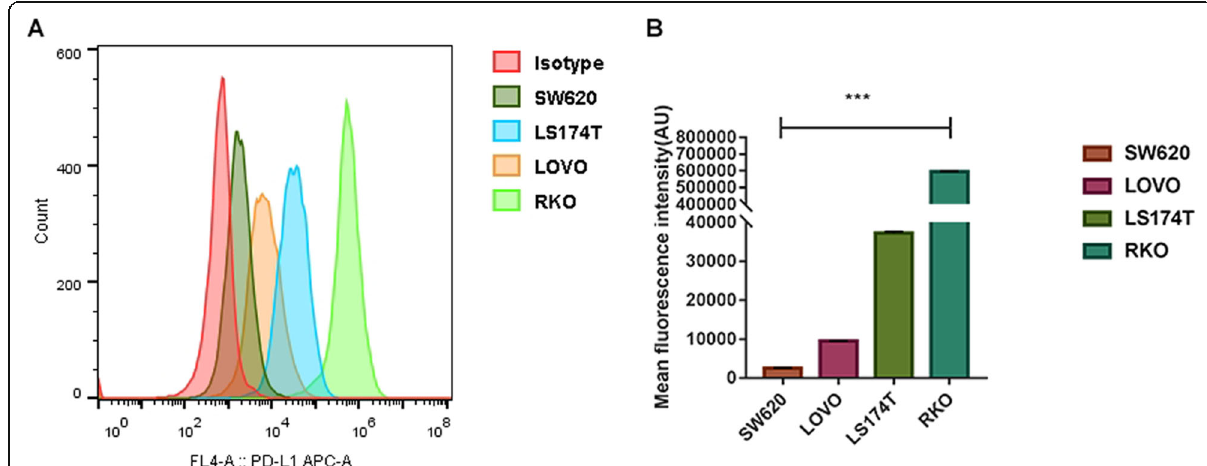
Fig. 2 The differences in the PD-L1 expression on the plasma membrane among LoVo, LS174T, SW620, and RKO was evaluated by flow cytometry analysis. a The analysis of anti-human PD-L1 antibody binding to the PD-L1 of plasma membranes in LoVo, LS174T, SW620, and RKO cell lines. b